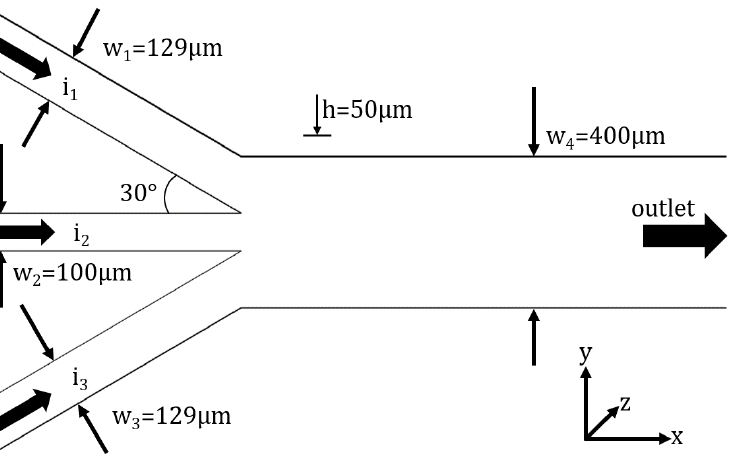
Figure 1. Microchannel geometry. The same fluid is introduced in branches 1 and 3 with the same flow rate, therefore we expect a symmetric interface in this